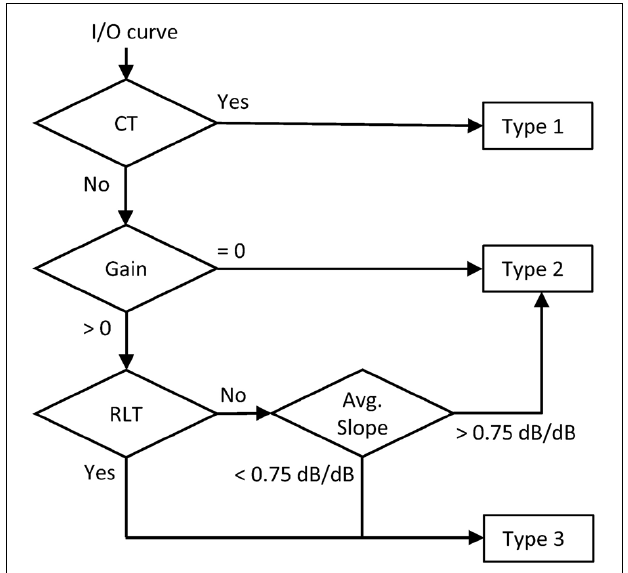
FIGURE 4 | Flow-diagram and logic used to classify each I/O curve into one of three categories: Type 1 = I/O curve with a compression threshold; Type 2 = Linear I/O curve; Type 3 = I/O curve with residual compression but no compression threshold.